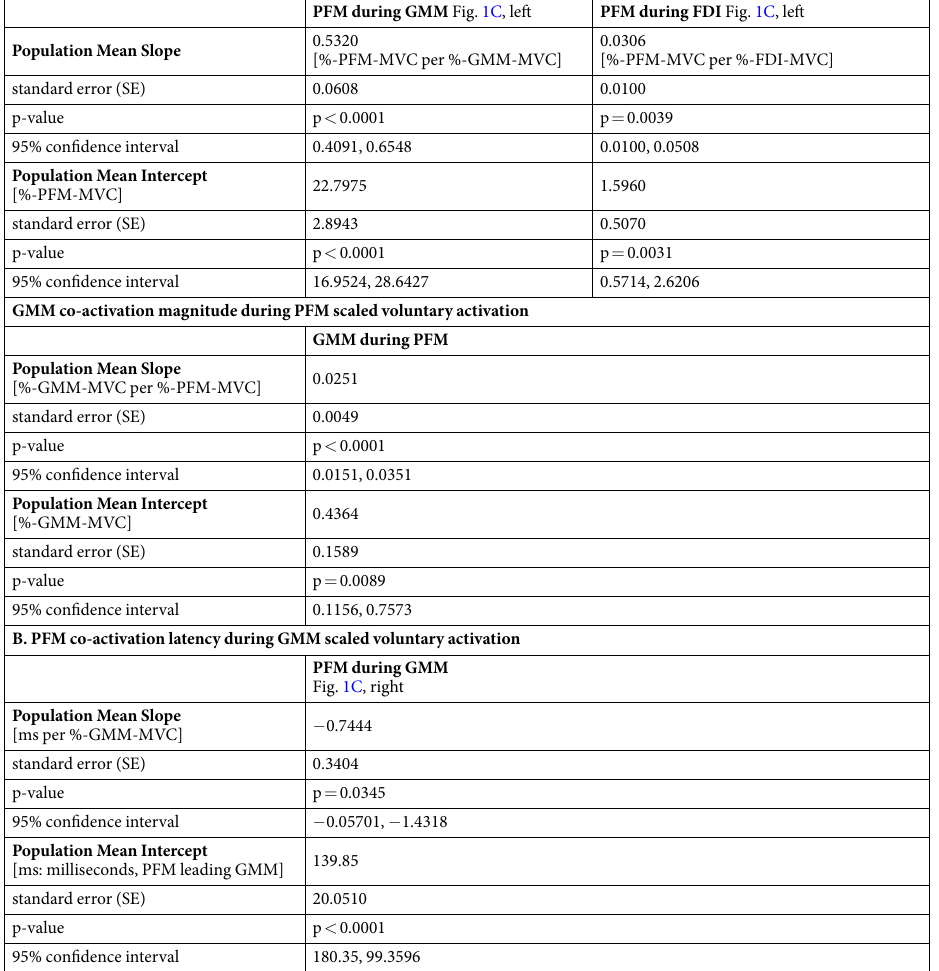
Table 1. Electromyographic (EMG) results during scaled voluntary muscle activation. PFM/FDI relation may not be meaningful since the increase in PFM co-activation magnitude is greater during GMM voluntary activation compared to voluntary FDI activation. Fig. 1C, left: estimated slope difference = 0.5066, SE = 0.1621, p = 0.0033, 95%CI (0.1790, 0.8343). PFM co-activation magnitude is greater during low GMM voluntary activation compared to low voluntary FDI activation. Fig. 1C, left: estimated intercept difference = 21.1847 [%-PFM-MVC], SE = 2.5868, p < 0.0001, 95%CI (15.9564, 26.4129). The increase in PFM co-activation magnitude during GMM voluntary activation is greater than the increase in GMM co-activation magnitude during PFM voluntary activation. Estimated slope difference = 0.4340, SE = 0.0115, p < 0.0001), 95%CI (0.4115, 0.4565). PFM co-activation magnitude during low GMM voluntary activation is greater than GMM co- activation magnitude during low PFM voluntary activation (estimated intercept difference = 24.0397, %-MVC, SE = 3.2886, p < 0.0001, 95%CI (17.3982, 30.6812). Positive co-activation latency means that PFM co-activation happened before the associated GMM voluntary activation. Statistics are based on linear mixed effects regression models; see METHODS section. PFM (pelvic floor muscles); GMM (gluteus maximus muscle); FDI (first dorsal interosseous